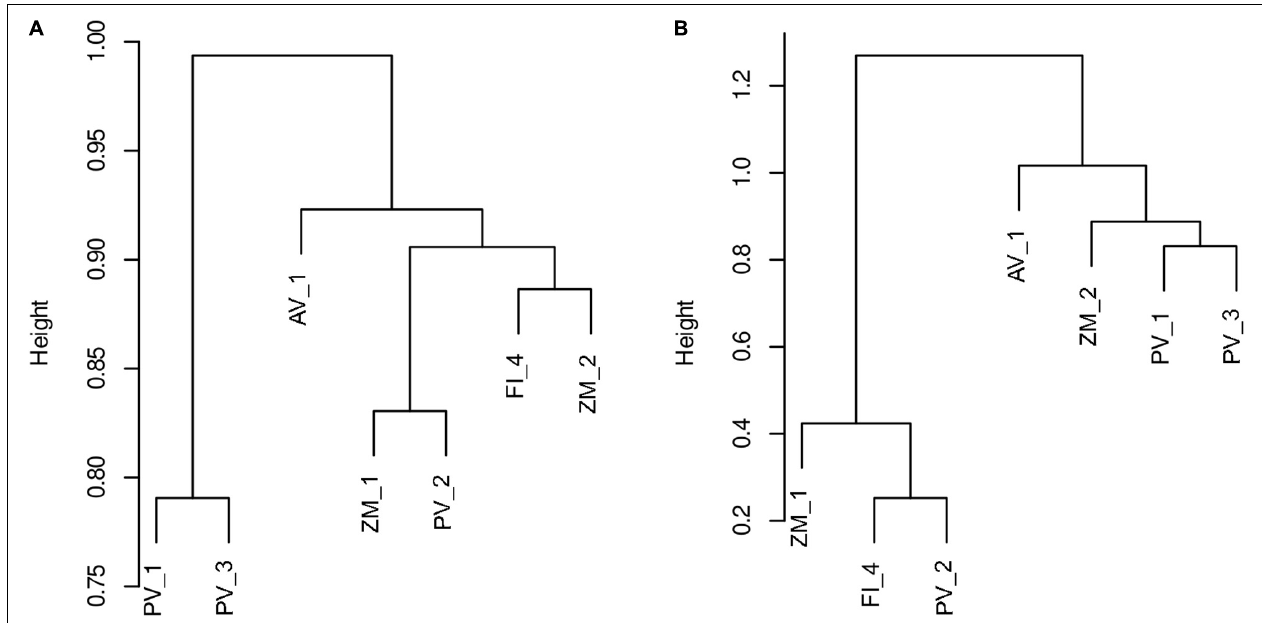
FIGURE 7 | Dendrogram generated using Ward’s clustering criterion showing dissimilarities of fungal communities in sediment samples from deep-sea low- and high-temperature hydrothermal vents, and an oxygen minimum zone based on Sorensen (A) and Bray-Curtis (B) metrics. Height indicates distance given the dissimilarity